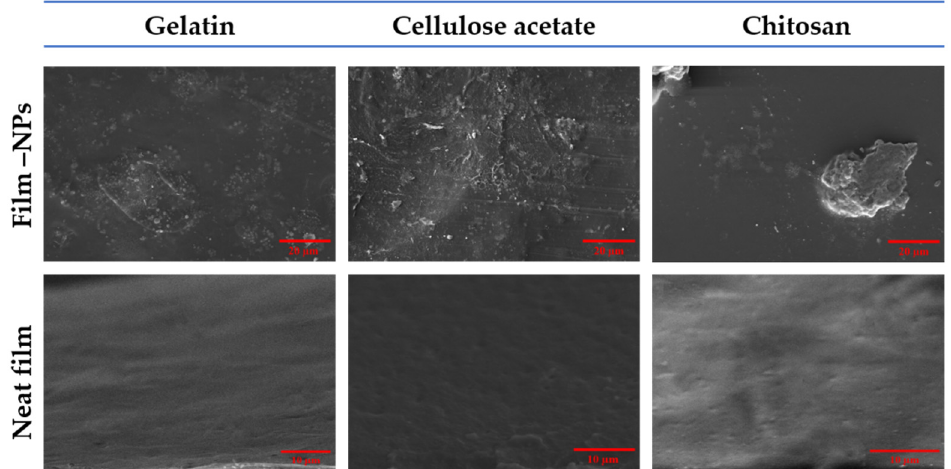
Figure 6. Scanning electron microscopy (SEM) images for the upper surfaces of the different films (gelatin-based, cellulose acetate-based, and chitosan-based composite films) with Fe x O y (1.0% w / w ). Neat films (gelatin-based, cellulose acetate-based, and chitosan-based films) without NPs incorpo- rated were included as the reference system.